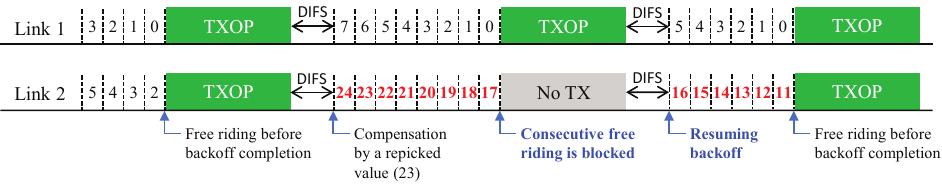
Figure 3. Proposal 1: limiting consecutive free-riding transmissions (backoff count values after compensation are colored red).